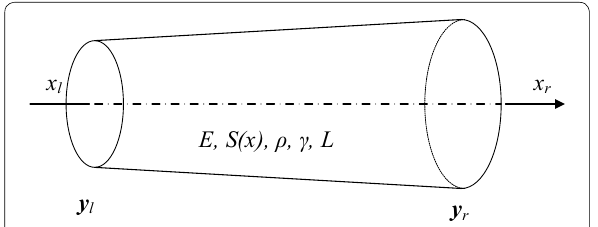
Figure 1 A schematic for a shaft with non-uniform